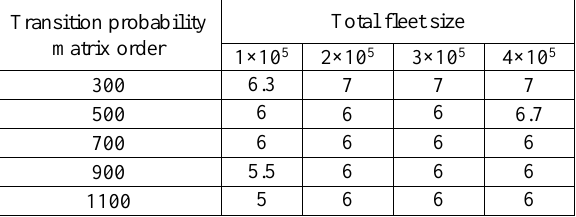
Table 2. The average convergence time of simulation data steady-state probability